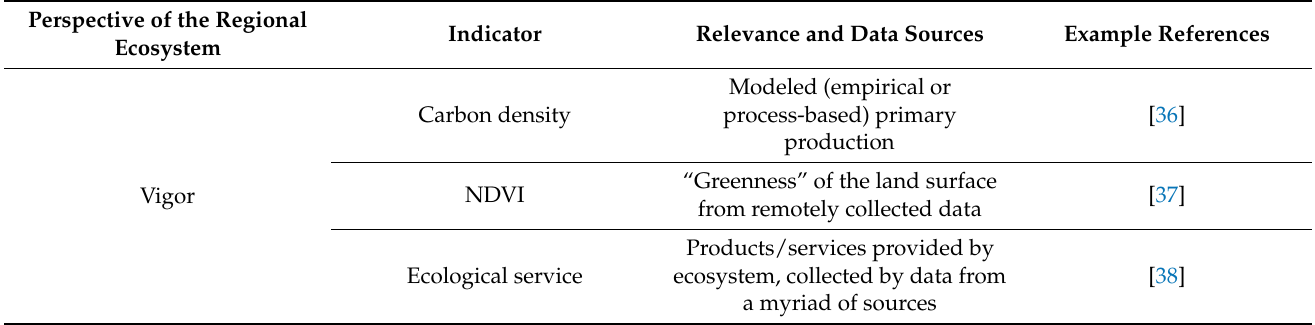
Table 1. Selected spatially continuous indicator candidates for ecosystem condition